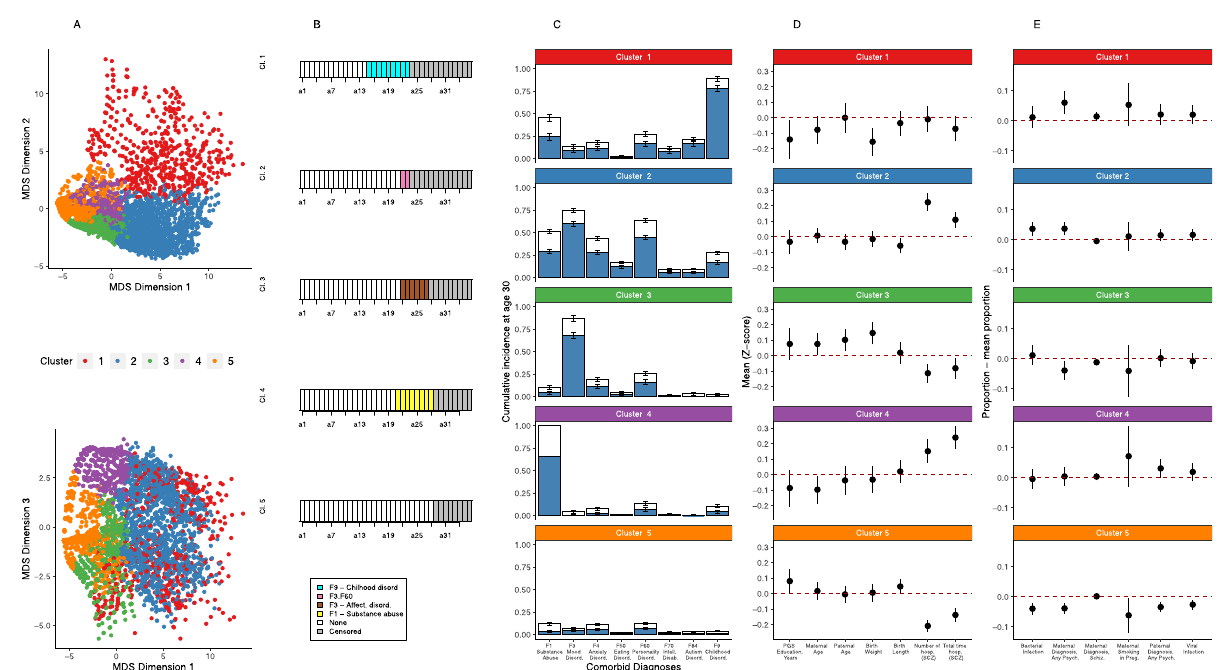
Fig. 4 Results of the multidimensional scaling and clustering based on dissimilarity of psychiatric comorbidity sequences in schizophrenia and cumulative incidence of comorbid psychiatric disorder categories and levels of risk factors and outcomes in each of the fi ve clusters identi fi ed. A Multidimensional scaling and clustering of the 5432 individuals with schizophrenia based on the dissimilarity in psychiatric comorbidity trajectories measured by sequence analysis. B The most frequent state at each time interval (modal sequence) of each of the fi ve clusters. C The cumulative incidence at age 30 of each comorbid diagnosis before (blue) and after (white) schizophrenia in each of the fi ve clusters of individuals with schizophrenia. Error bars are 95% con fi dence intervals. Sample sizes are: Cluster 1: ( N none / N before / N after ) F1: 321/129/103; F3: 517/50/24; F4: 490/66/33; F50: 581/<15/<6;